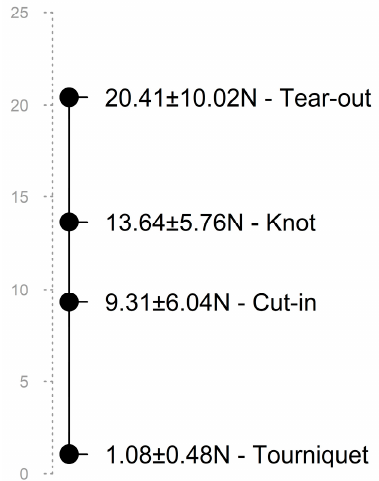
Figure 5. Virtual scale with all average force levels taken from the current and our previous study [7]. Even if the comparison is possible only to a limited extent, it can be seen that the tear-out force is far apart from the forces exerted by knots or tourniquets and unlikely to be reached. However, tying manual knots implies peak forces that exceed or come close to the cut-in threshold. In contrast, tightening of a tourniquet is least likely to cause damage due to its low strength.